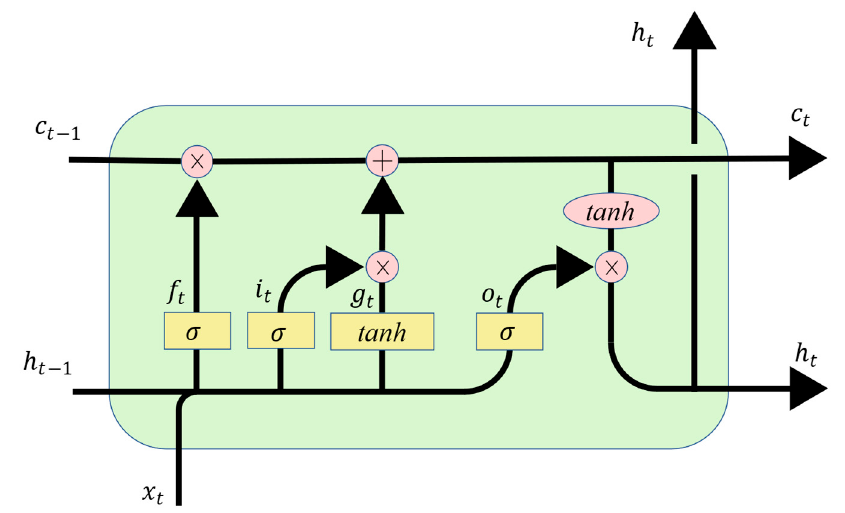
Figure 26. The cell structure of LSTM.